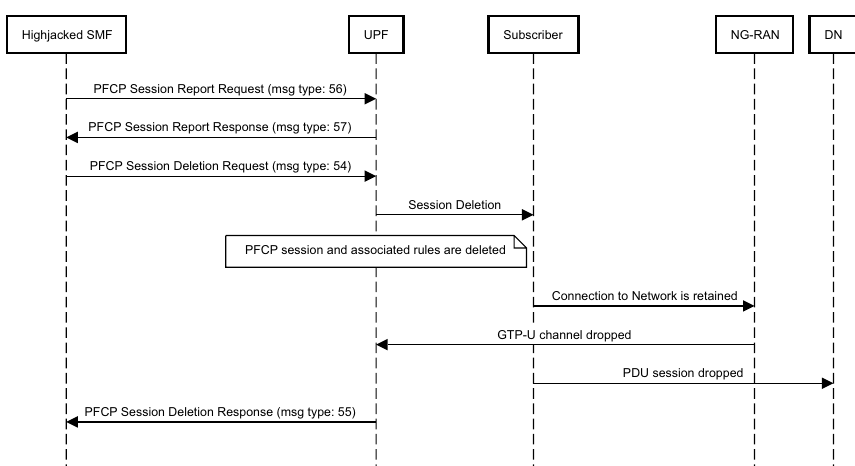
Fig. 3 Session Deletion DoS attack: A UML sequence diagram for the session deletion